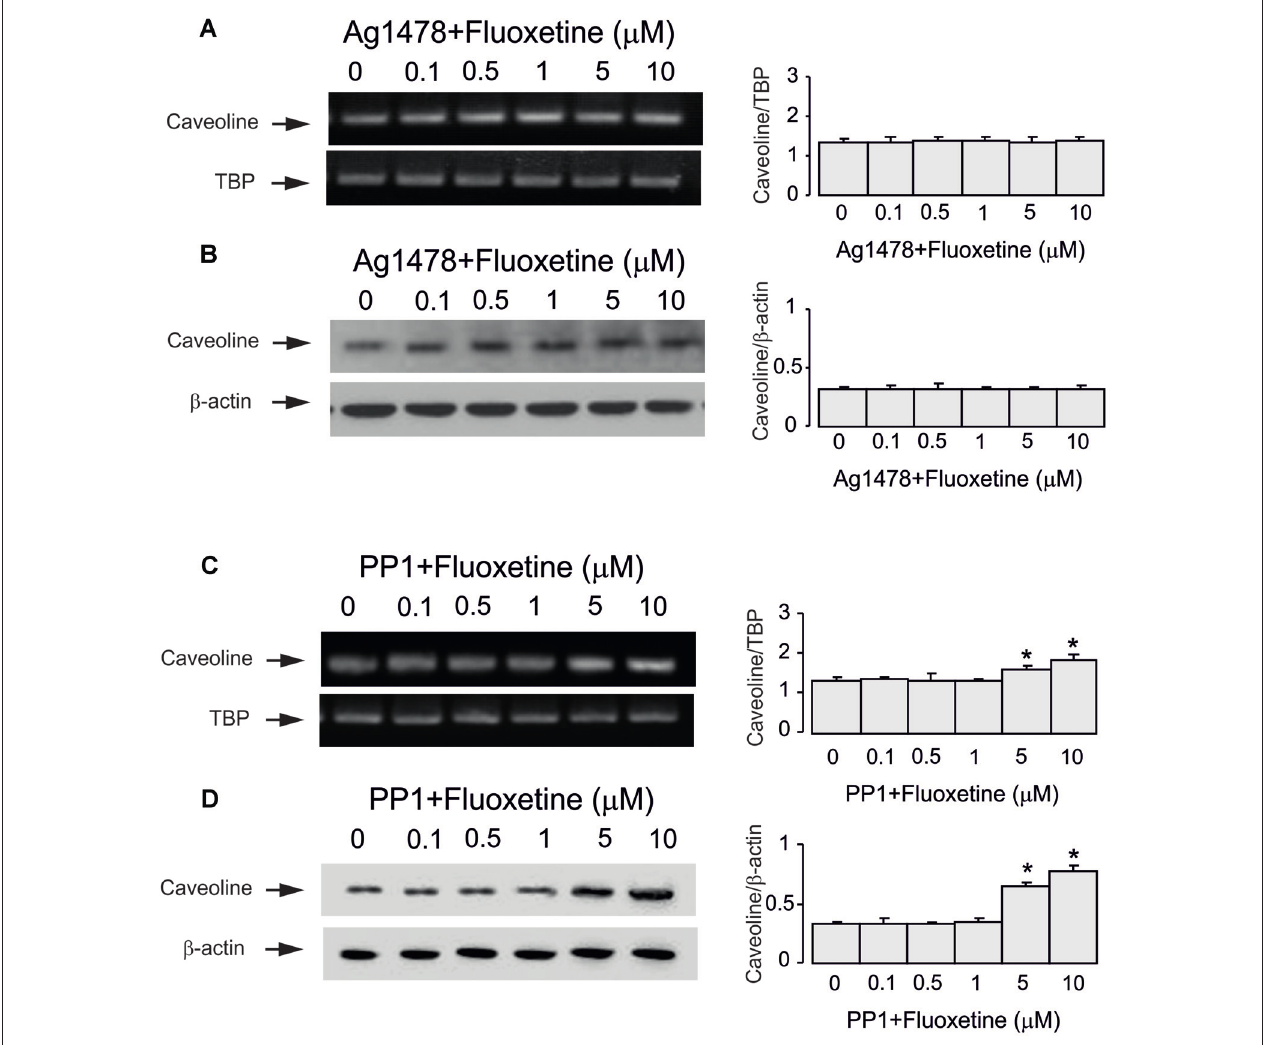
FIGURE 4 | Regulation of mRNA and protein expression of Cav-1 by chronic treatment with fluoxetine requires epidermal growth factor receptor (EGFR) or Src activation in astrocytes. Cells were incubated for 2 weeks without any drug (0 µ M fluoxetine, control) or with 0.1, 0.5, 1, 5, or 10 µ M fluoxetine in the presence of AG1478, an inhibitor of EGFR or PP1, an inhibitor of Src. (A,C) Southern blots from representative experiments. Similar results were obtained from three independent experiments. Average mRNA expression was quantitated as ratio between Cav-1 and TBP, used as a house-keeping gene. (B,D) Immunoblots from a representative experiments. Similar results were obtained from three independent experiments. Average protein expression was quantified as ratio between Cav-1 and β -actin, used as a house-keeping gene. SEM values are indicated by vertical bars. ∗ Indicates statistically significant ( P < 0.05) difference from all other groups but not from each